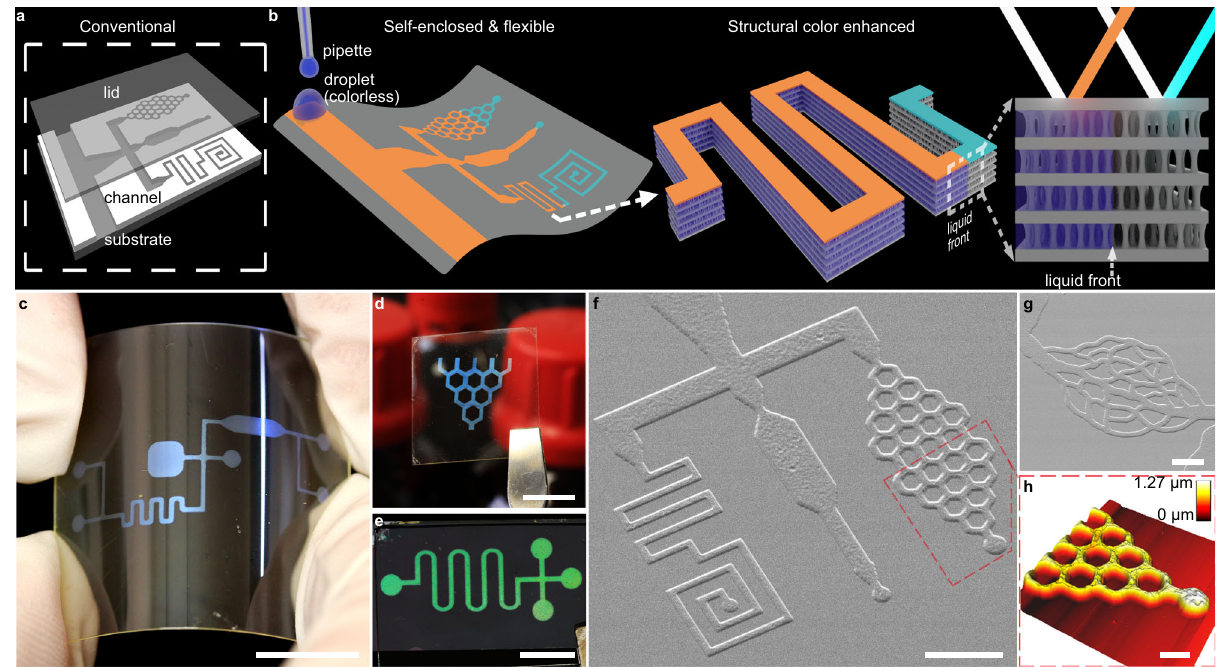
Fig. 1 Self-enclosed fl exible micro fl uidics with intrinsic structural colour. a Conventional lithographic techniques for micro fl uidic devices require a sealing step, as shown by the schematic. b Illustration for micro fl uidics made by organized micro fi brillation (OM). Flow-induced colour change (as depicted from cyan to orange) results from liquid in fi ltration changing the optical property of the periodic OM structure. c – e Macro lens photos of OM channel printed on different substrates: ( c ) poly(ethylene terephthalate) (PET) sheet, ( d ) cover glass, and ( e ) silicon wafer. f , g SEM images for OM micro fl uidics with ( f ) a complex channel and ( g ) a capillary-like pattern, respectively. h , AFM image for the same OM microchannel in ( f ). Scale bar, ( c – e ) 1 cm, ( f ) 50 μ m, ( g ) 10 μ m, ( h ) 20 μ